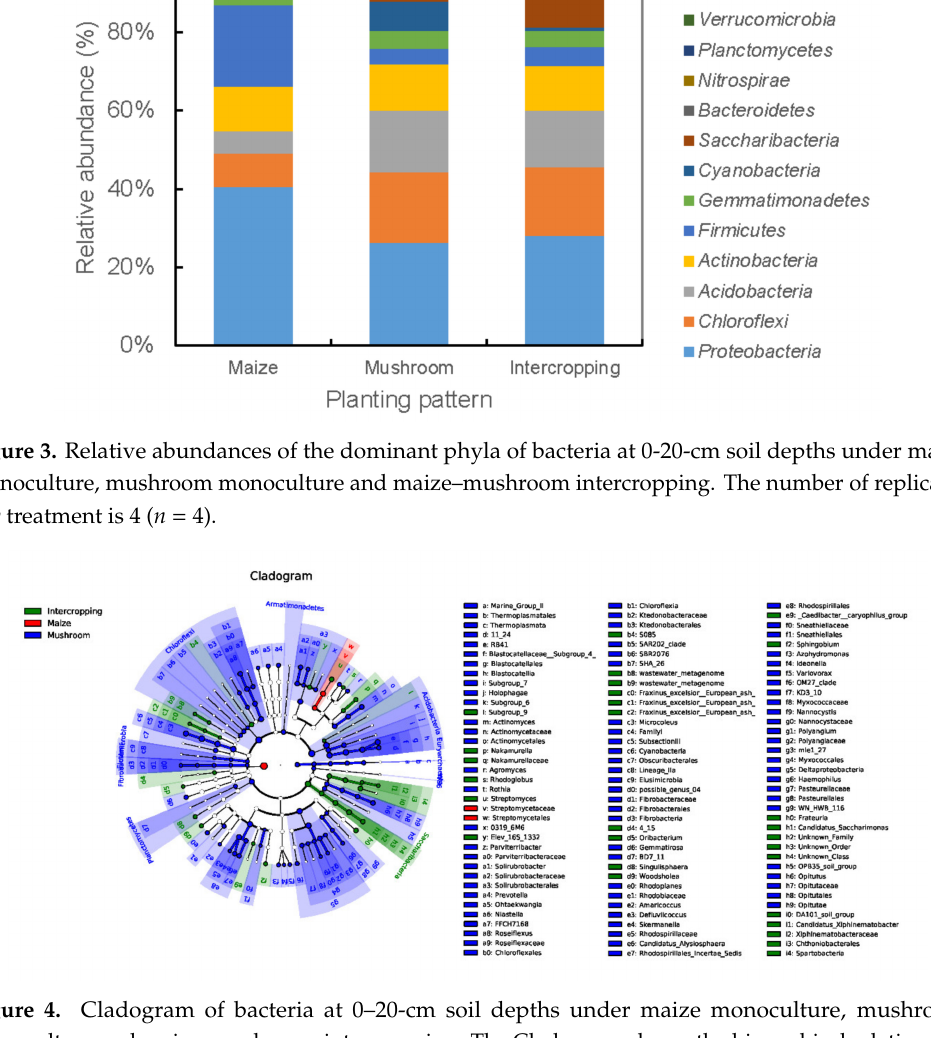
Figure 4. Cladogram of bacteria at 0–20-cm soil depths under maize monoculture, mushroom monoculture and maize–mushroom intercropping. The Cladogram shows the hierarchical relationship of all classification units from the phylum to the genus (from the inner circle to the outer circle). The node size corresponds to the average relative abundance of the classification units. The blue, green and red node represents that the di ff erence of bacterial relative abundance between groups is significant. The letters identify the taxon name that has a significant di ff erence between groups. The number of replicates per treatment is 4 ( n =